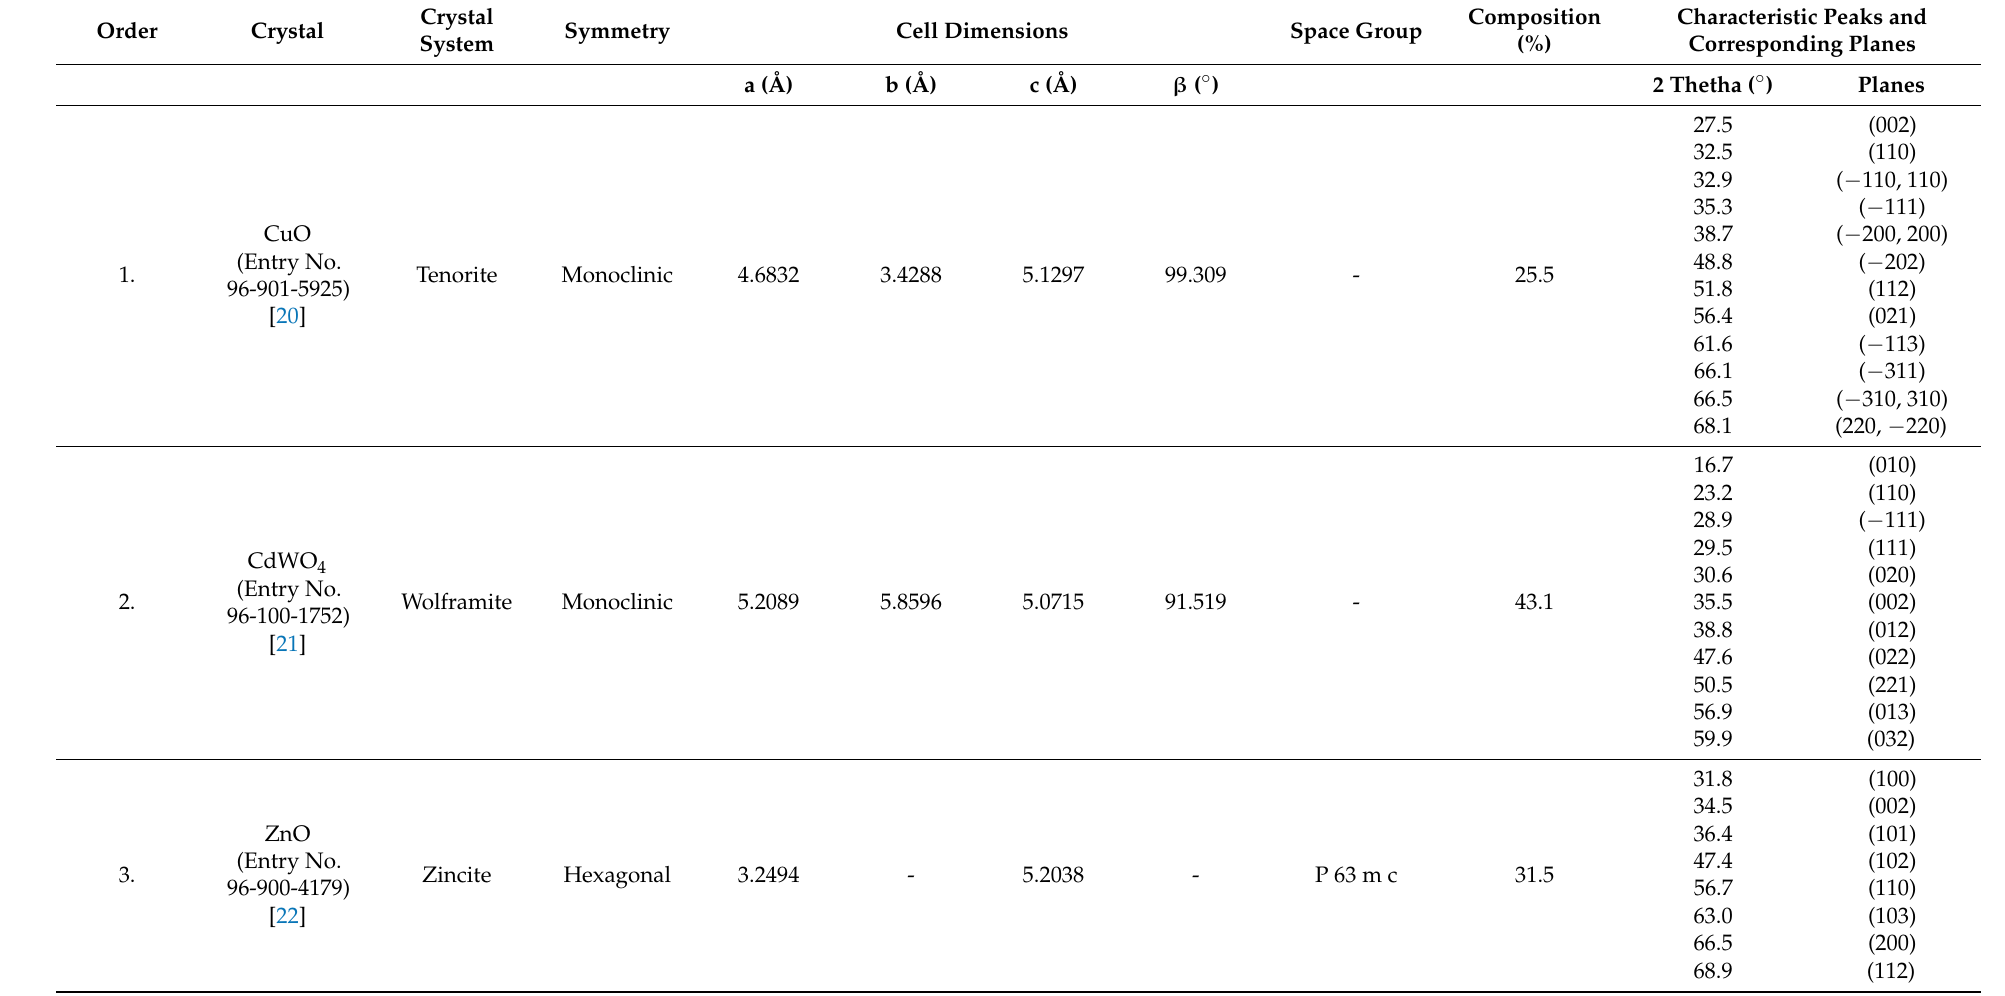
Table 1. XRD analysis of